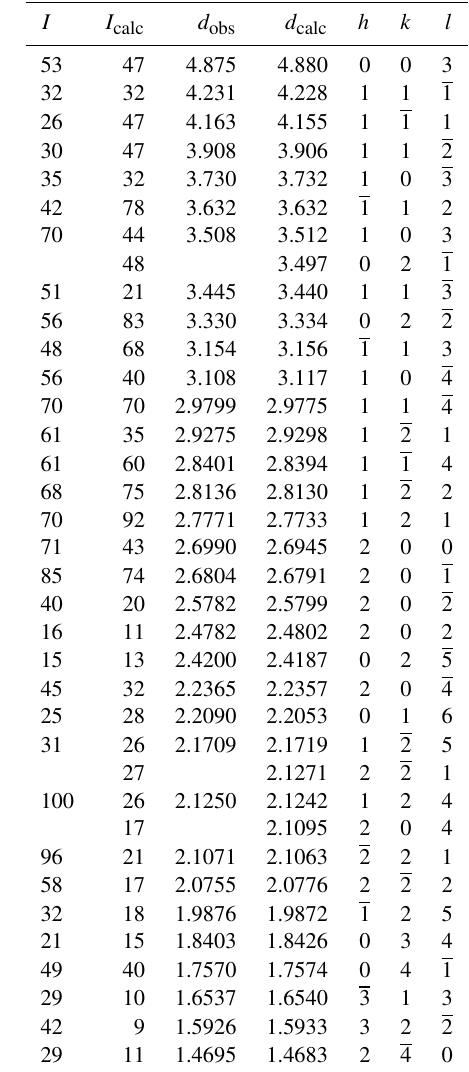
Table 4. Powder X-ray diffraction data ( d inÅ) for